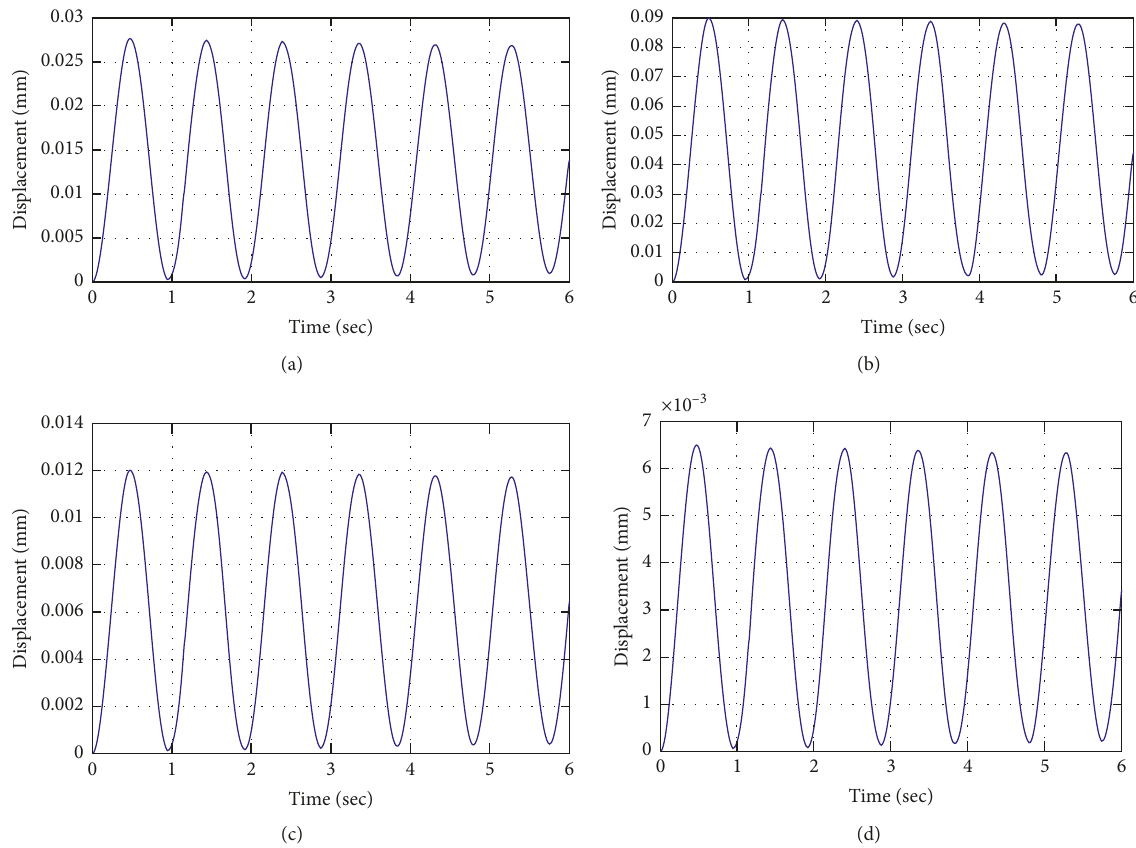
Figure 10: Displacement for flat face plug with flow velocity 1m/s and different valve opening. (a) 10% valve opening; (b) 20% valve opening; (c) 30% valve opening; (d) 40% valve opening.